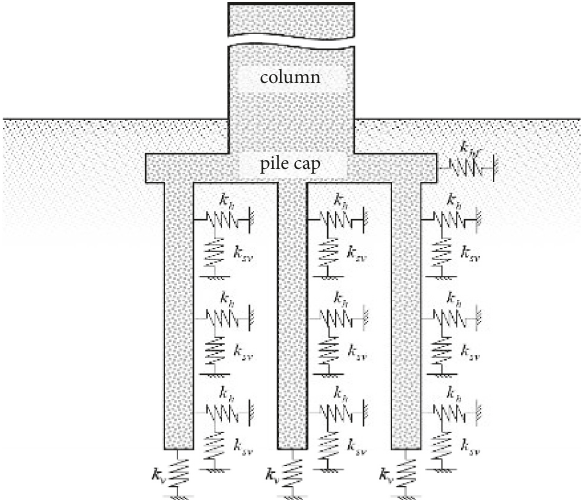
Figure 3: Setting of the soil spring in the numerical